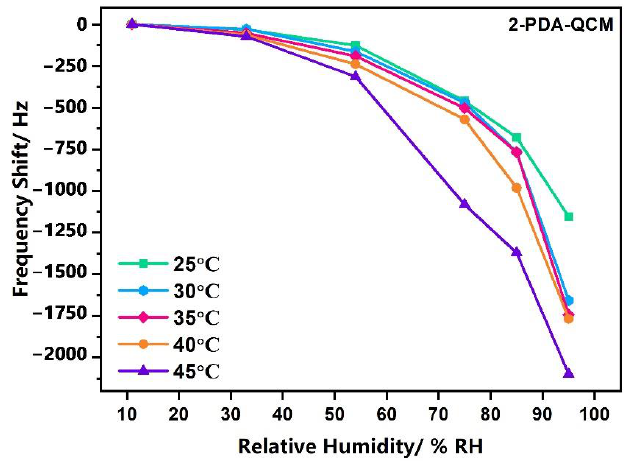
Figure 7. The frequency shifts of 2-PDA-QCM at different temperatures.